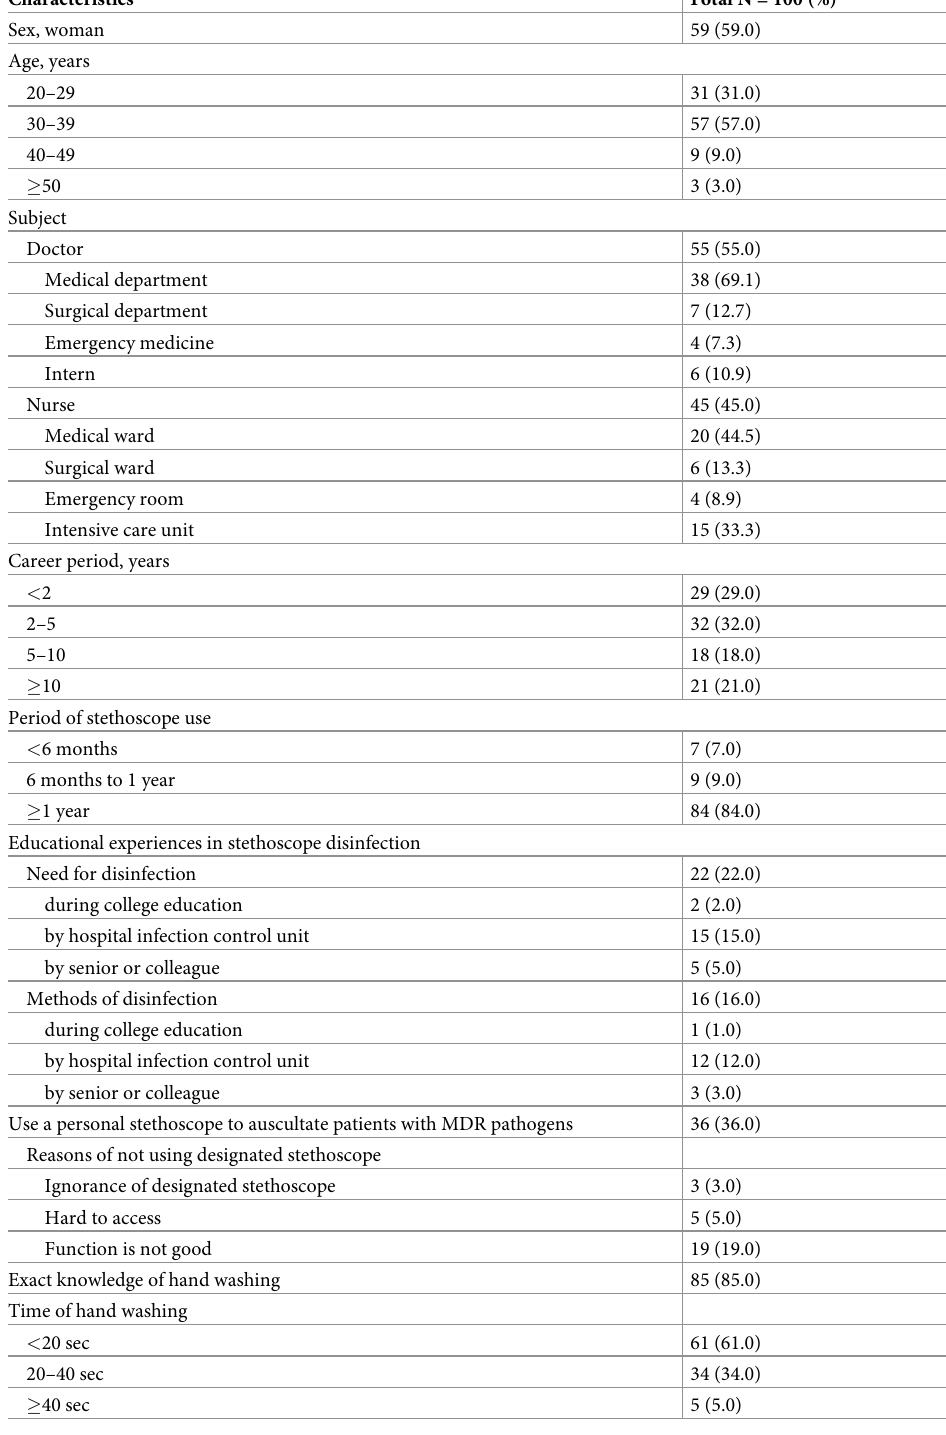
Table 1. Demographic characteristics and pre-intervention status of the